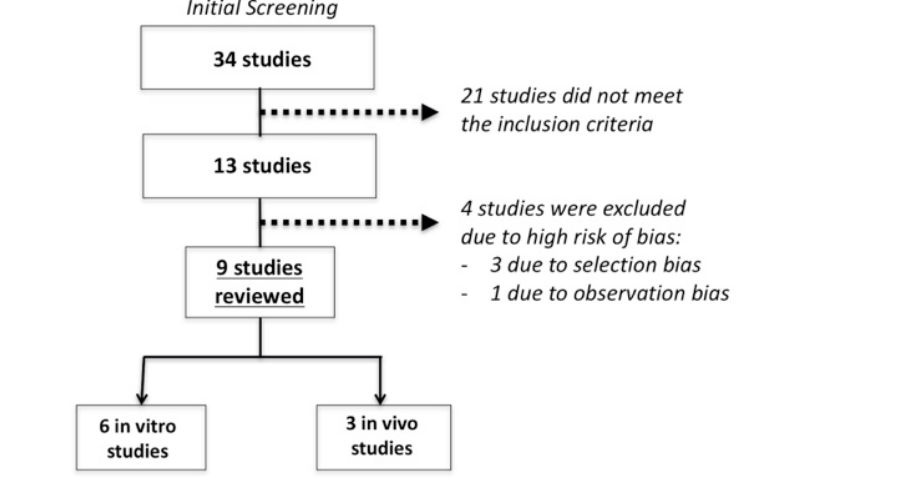
Figure 1. Flowchart of the systematic review. Table 1. Characteristics of the studies